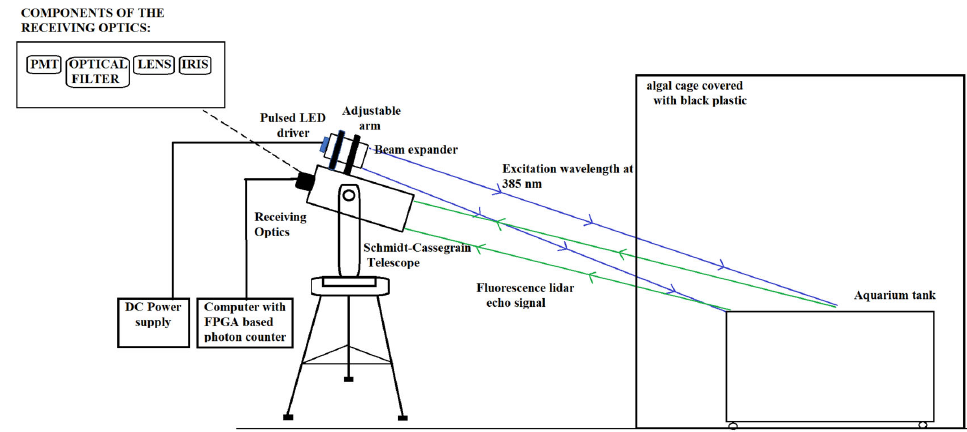
Figure 1. The design of the pulsed LED fluorescence lidar system. The arrow diagram represents the excitation beam from the transmitting component and fluorescence backscatter signal from the algal tank [28].